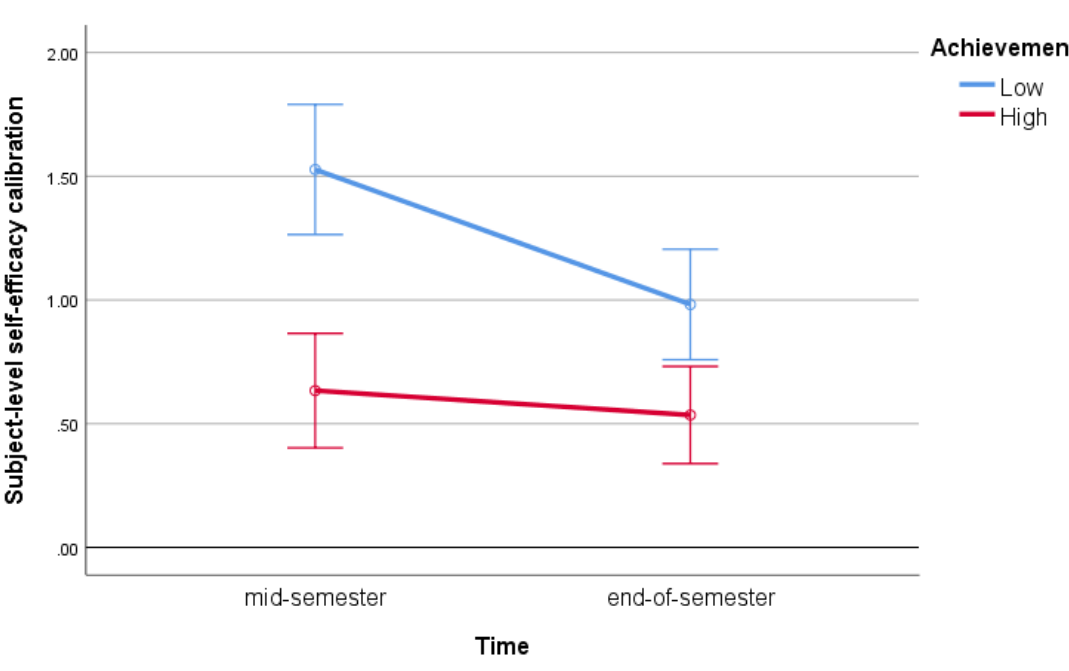
Subject-level Self-efficacy Bias Over Time and by Achievement Level